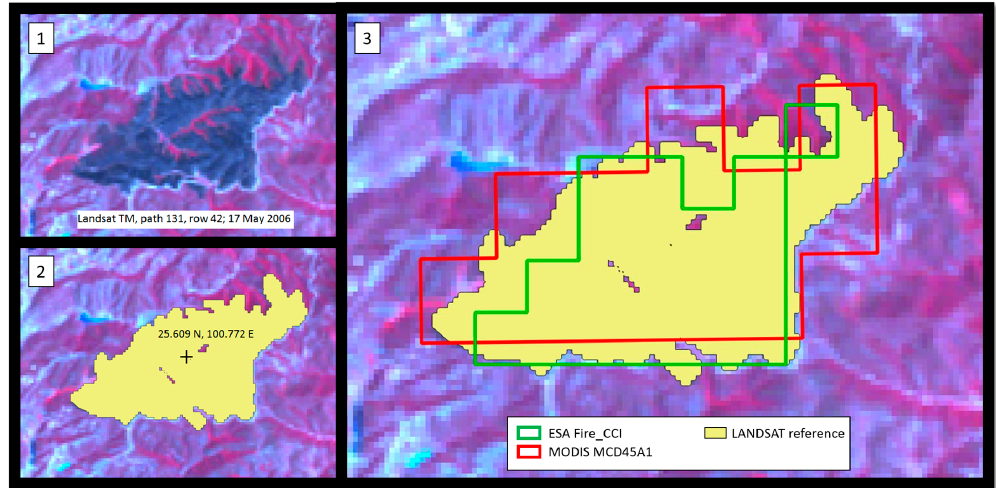
Figure 2. Example of polygon intersection assessment: ( 1 ) Burn scar visible on Landsat false color infrared composite; ( 2 ) Reference dataset manually mapped burn polygon; ( 3 ) European Space Agency’s (ESA’s) Fire_CCI and MCD45A1 products overlay. Despite both products show different degrees of omission and commission errors at a sub-pixel level, in our accuracy assessment, the two detections of the fire event are considered equally successful.